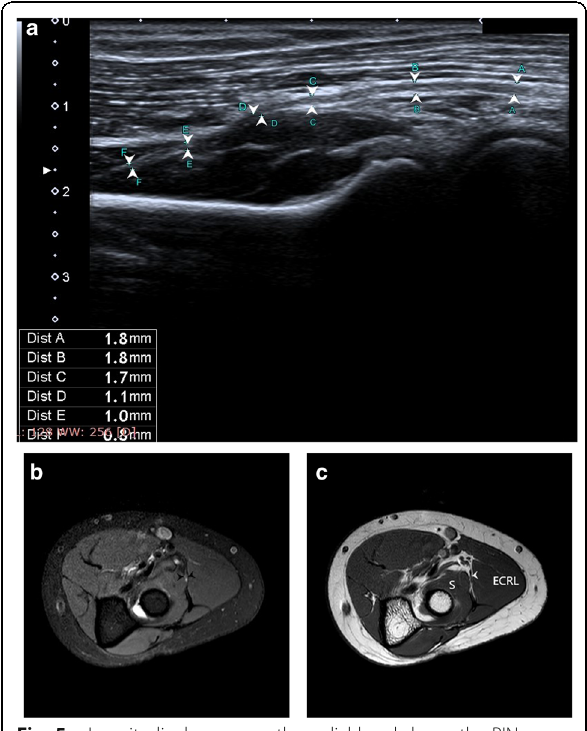
Fig. 5 a Longitudinal scan over the radial head shows the PIN (between arrowheads) coursing over the radial head and passing through the radial tunnel. The nerve is hypoechoic and thickened just before passing through the arcade of Frohse in a patient with radial tunnel syndrome. b PD FS axial image shows hyperintense PIN with bulbous swelling just before it pierces the arcade of Frohse, lying between the distal edge of ECRL and superficial supinator. c T1-weighted axial image shows the course of the PIN soon after its division from the radial nerve passing between the ECRL and supinator. The diagnosis of radial tunnel syndrome was confirmed in this patient by giving ultrasound-guided PIN block